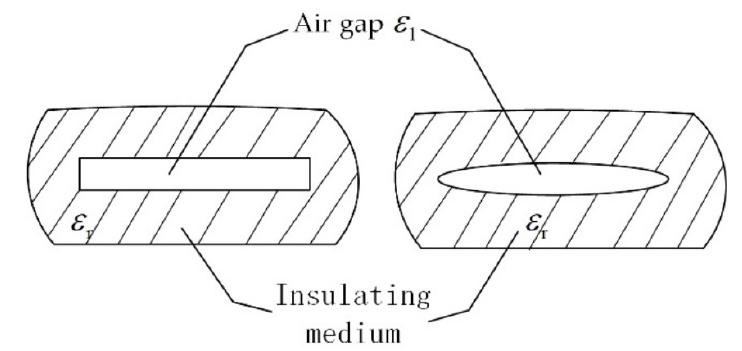
Figure 1. The model of air gap in an insulation board.